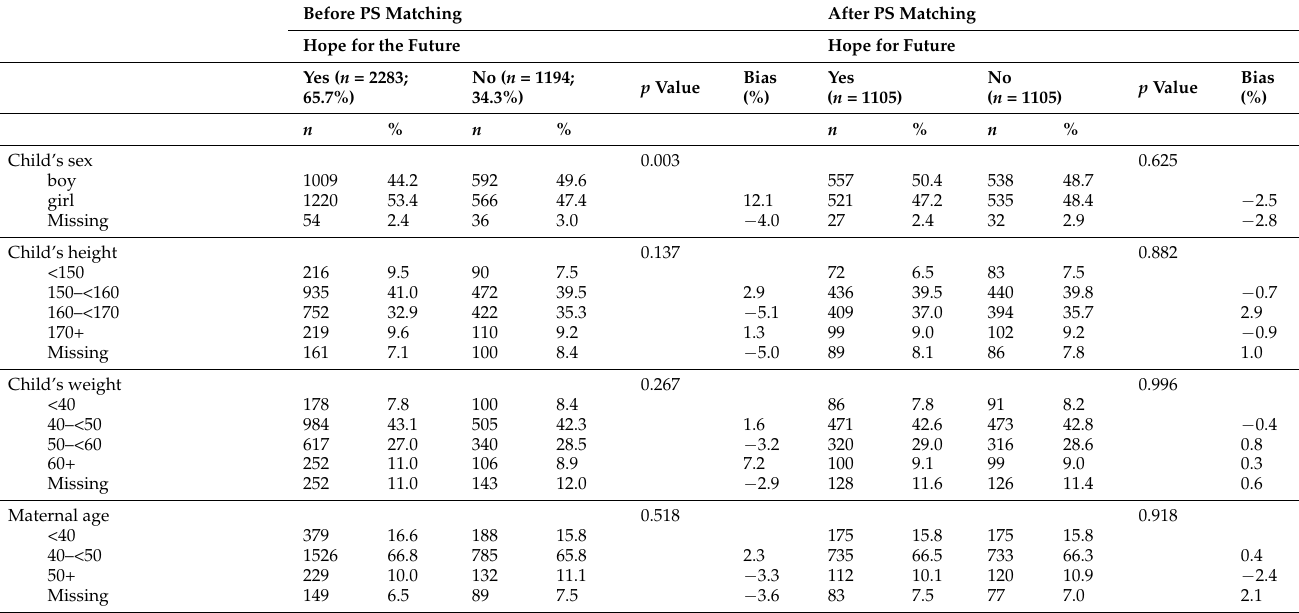
Table 1. Characteristics of covariates before and after propensity score